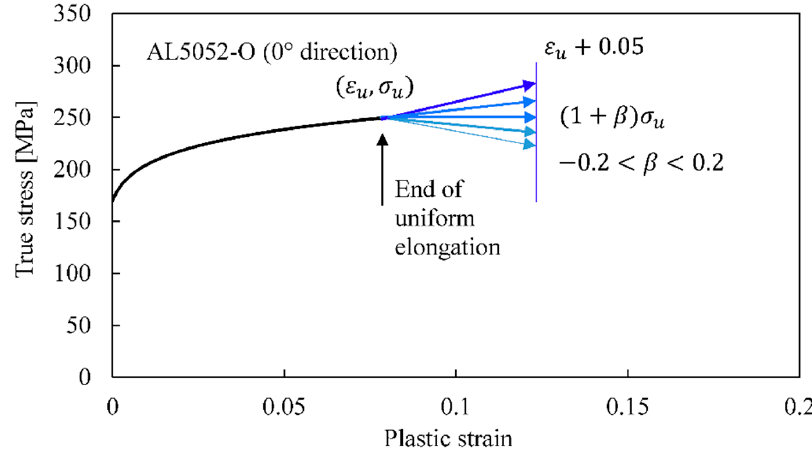
Figure 7. Stress integration scheme at extrapolation range of strain.